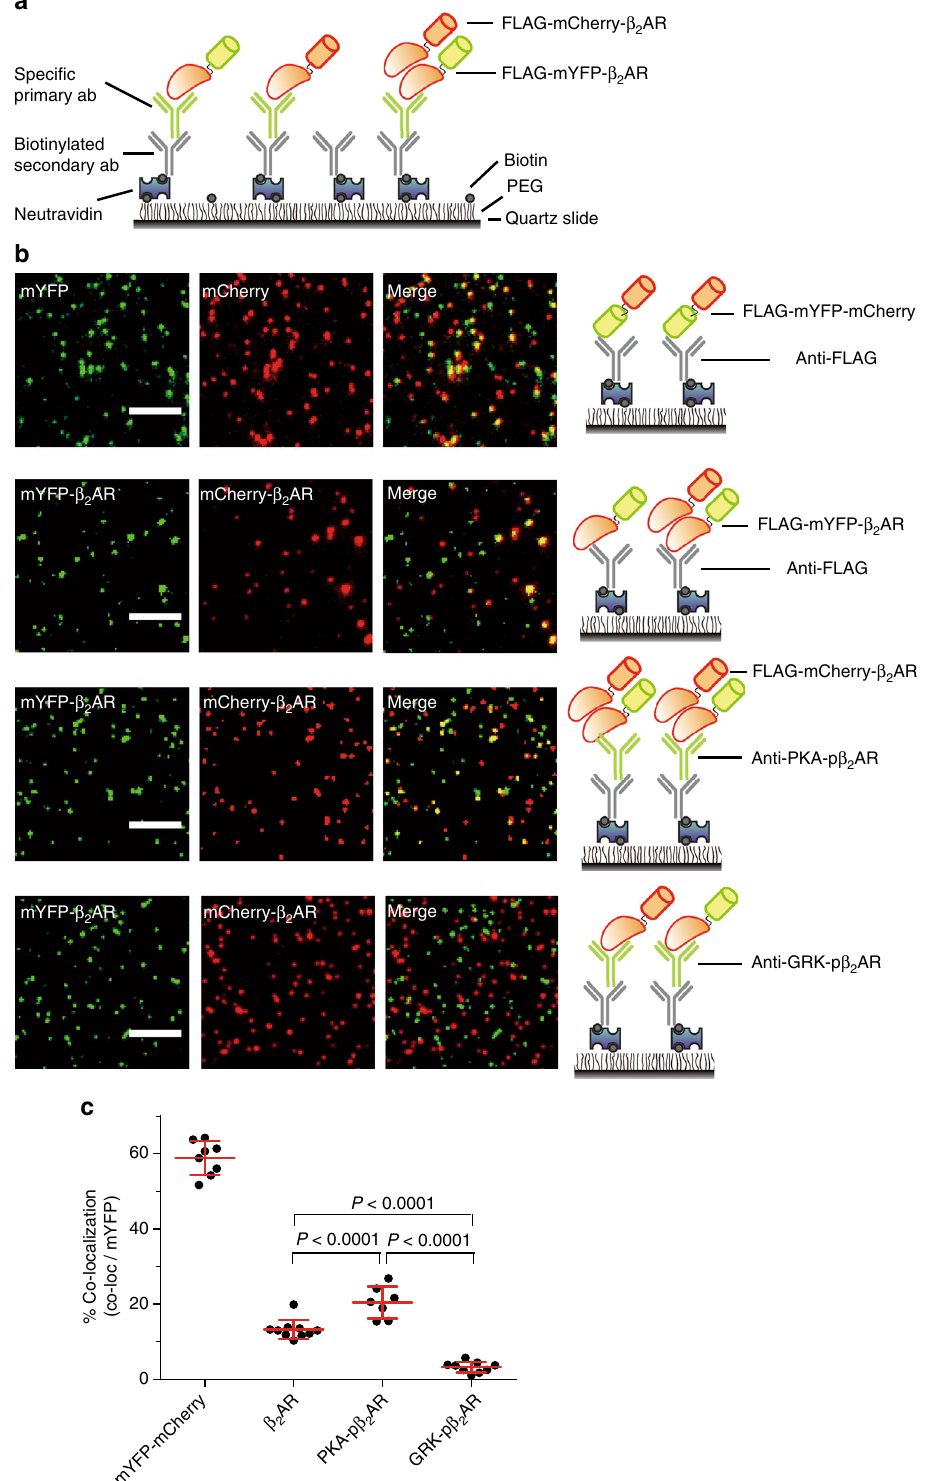
Fig. 3 PKA- and GRK-p β 2 AR display minimal overlap at the single-molecule level. a Schematic of single-molecule pulldown (SiMPull) assay. b Representative SiMPull images of a fusion mCherry-mYFP protein, total β 2 AR, PKA-phosphorylated β 2 AR, and GRK-phosphorylated β 2 AR pulled down from cell lysates expressing mCherry- β 2 AR and mYFP- β 2 AR at 1:1 ratio. Scale bar, 5 μ m. Representative of n = 8, 10, 7, and 9 images, respectively, three independent experiments. c Quanti fi cation of overlap percentage between mCherry and mYFP from images in b ( n = 8, 10, 7, and 9, respectively). Error bars denote s.d.; multiplicity adjusted P values are computed by one-way ANOVA followed by Tukey ’ s test between indicated